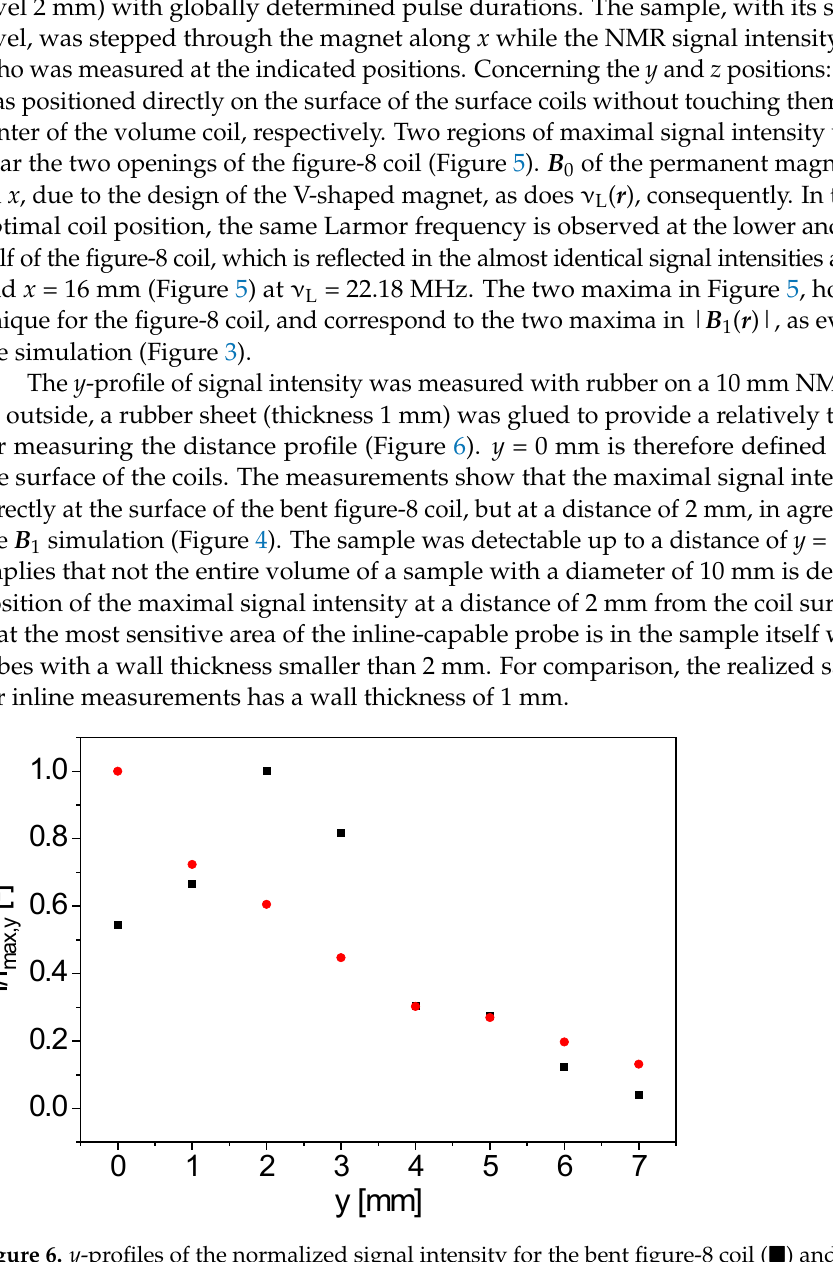
Figure 6. y -profiles of the normalized signal intensity for the bent figure-8 coil ( ■ ) and the spirally wound, bent surface coil ( • ), measured with a thin rubber sample. The maximal signal intensity for the spirally wound, bent surface coil is near the surface of the coil, whereas the maximum for the bent figure-8 coil is shifted by around 2 mm in the y -direction.